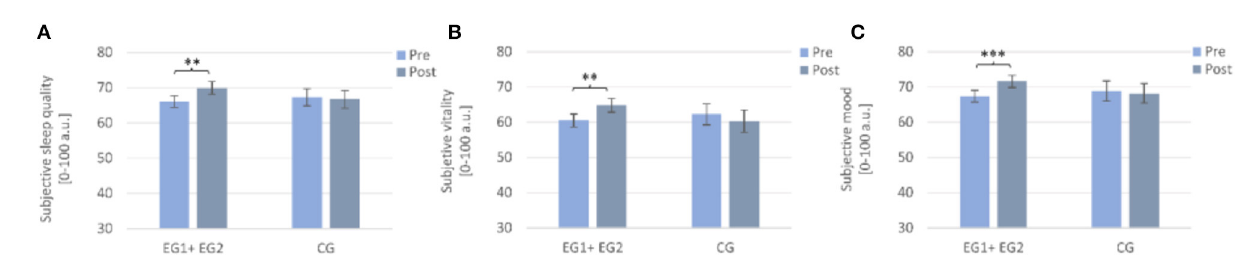
FIGURE4 Subjectively assessed changes from pre to post in the sleep intervention group (EG1 + EG2) compared to the waiting-list control group (CG). Note that the sleep intervention group improved significantly from pre to post in (A) sleep quality, (B) subjective vitality, and (C) subjective mood. Pre- and post-measurements were assessed daily and averaged over a week each. Asterisks represent significant results, ** p < 0.01, *** p < 0.001. Error bars display ± 1 standard error. EG1 + EG2, pooled sleep intervention group (experimental group one + experimental group two); CG, control group.